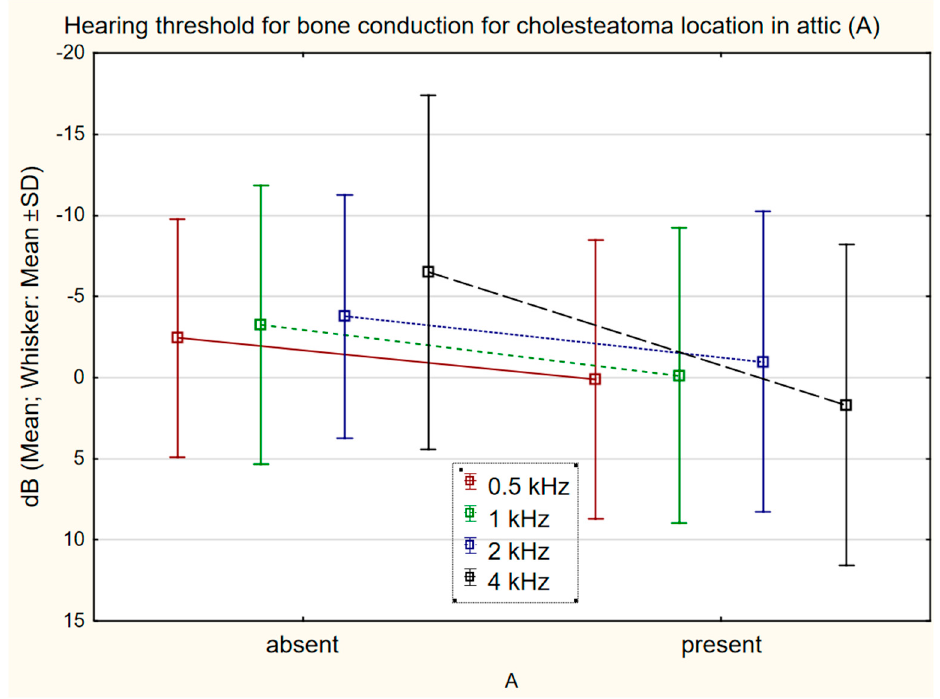
Figure 3. The difference in bone conduction prior to surgery and 1 year after surgery in presence ( n = 83) or absence ( n = 37) of cholesteatoma in the attic (A) at 4 kHz 1.69 dB (SD 9.92)/ − 6.49 dB (SD 10.92) ( p = 0.0001).